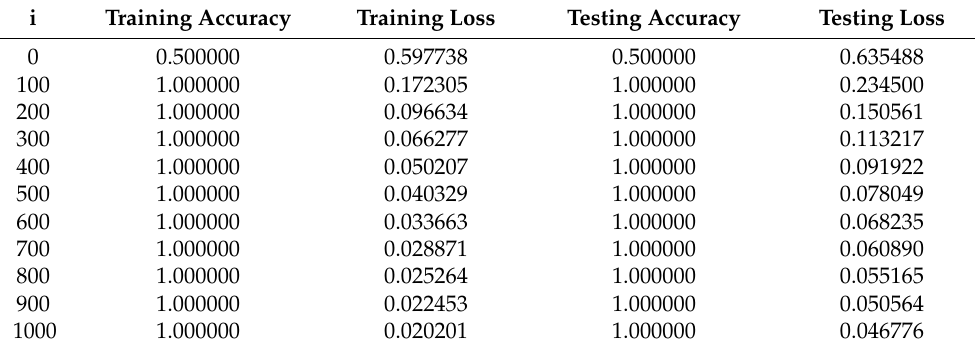
Figure 6. Schematic diagram of R-B in logistic regression. ( a ) Schematic diagram of training dataset. ( b ) Schematic diagram of testing dataset. Table 2. The accuracy and loss rate of training dataset and testing dataset in R-B logistic